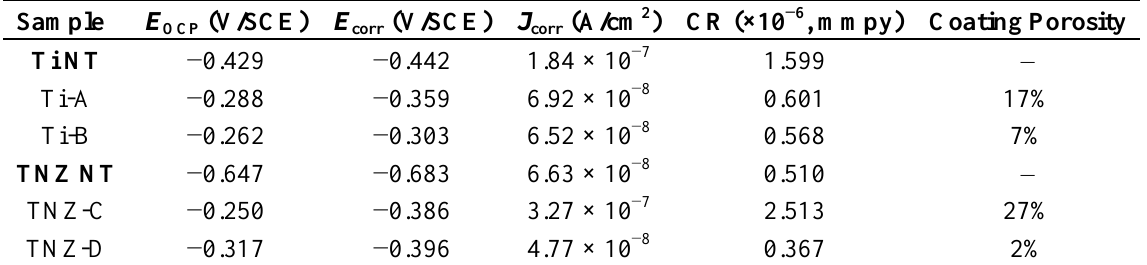
Table 2. Open-circuit potential ( E ( J ), corrosion rate (CR) and coating porosity extrapolated from the potentiodynamic corr polarization curves. The errors in the E for J the value is typically around 0.1 × 10 −8 A/cm 2 . corr